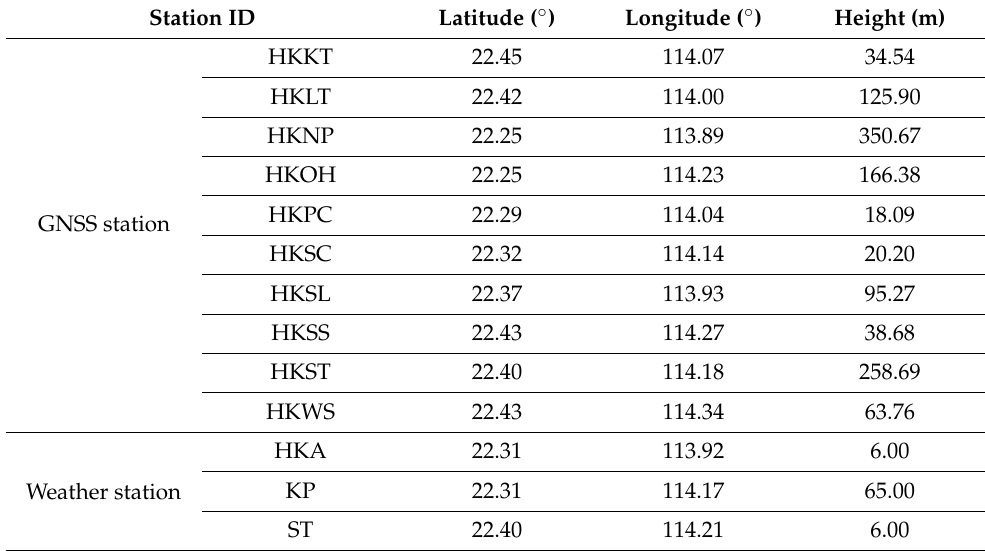
Table 1. Coordinate information of the selected GNSS and weather